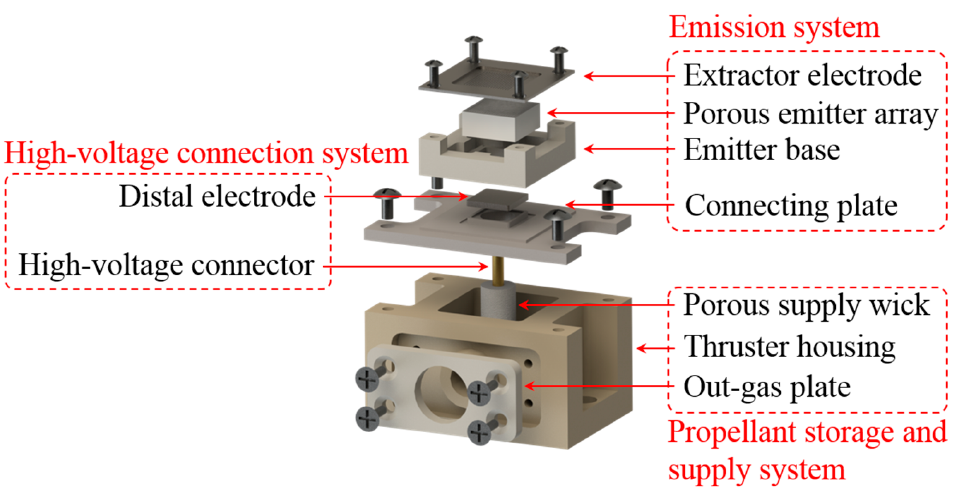
Figure 1. Exploded view of the ILET assembly.